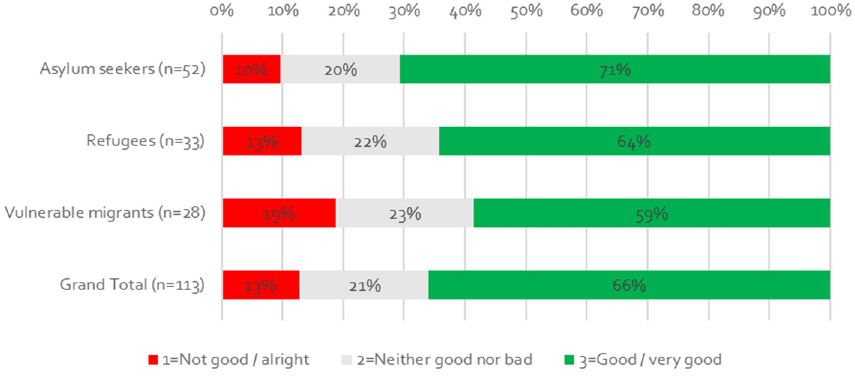
Figure 5. Average opinion on the chat bot.